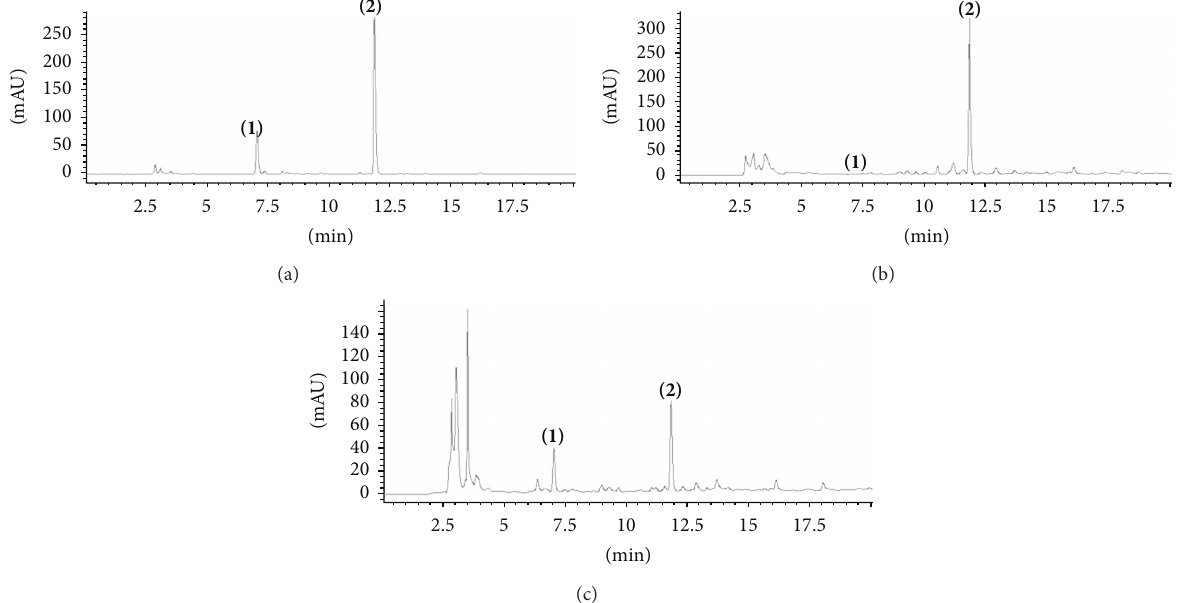
Figure 3: HPLC chromatograms of standards of eleutherosides B ( 1 ) and E ( 2 ) (a) and of the MeOH extracts from A. divaricatus grown with fertilizer ratio N-2P-K (b) and from A. koreanum grown with fertilizer ratio 2N-2P-2K